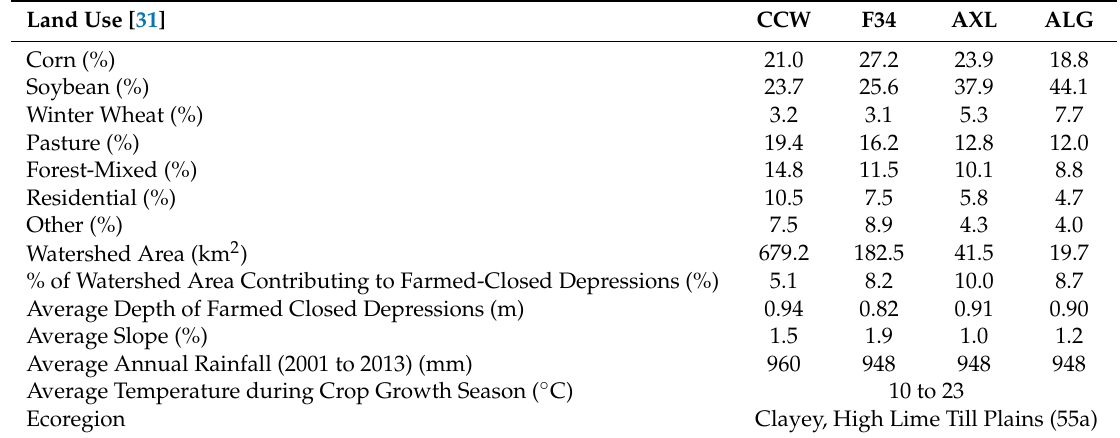
Table 1. Watershed characteristics including land use distribution, area, average slope, and average annual climate conditions for the study